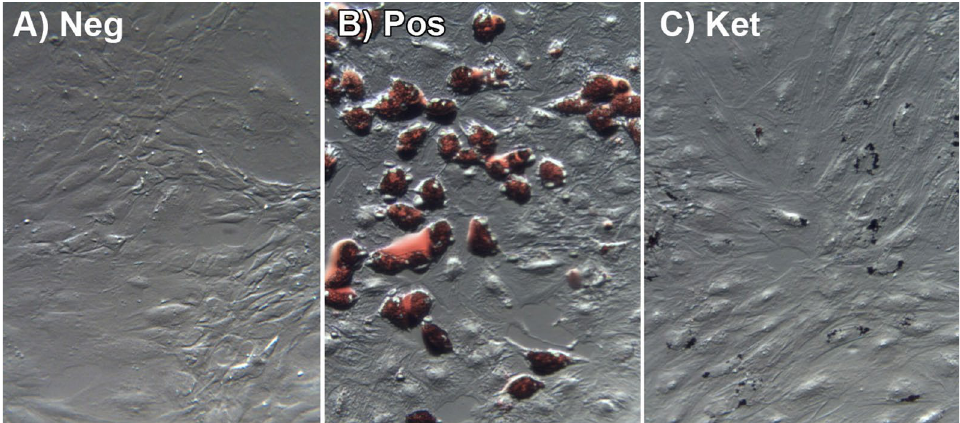
Figure 2. Ketanserin blocks terminal human adipocyte differentiation (Day 14). Human pre-adipocytes were differentiated for 14 days and then stained with oil red O to assess lipid accumulation as a marker for adipocyte differentiation. ( A ) Negative control cells that were maintained in basal medium for 14 days did not stain, indicating no differentiation. ( B ) Induced positive control cells stained with oil red O, indicating differentiation into mature adipocytes with lipid accumulation. ( C ) Induced positive control cells that were treated with ketanserin (1.0 µM) for 14 days showed no staining, indicating blockade of adipocyte